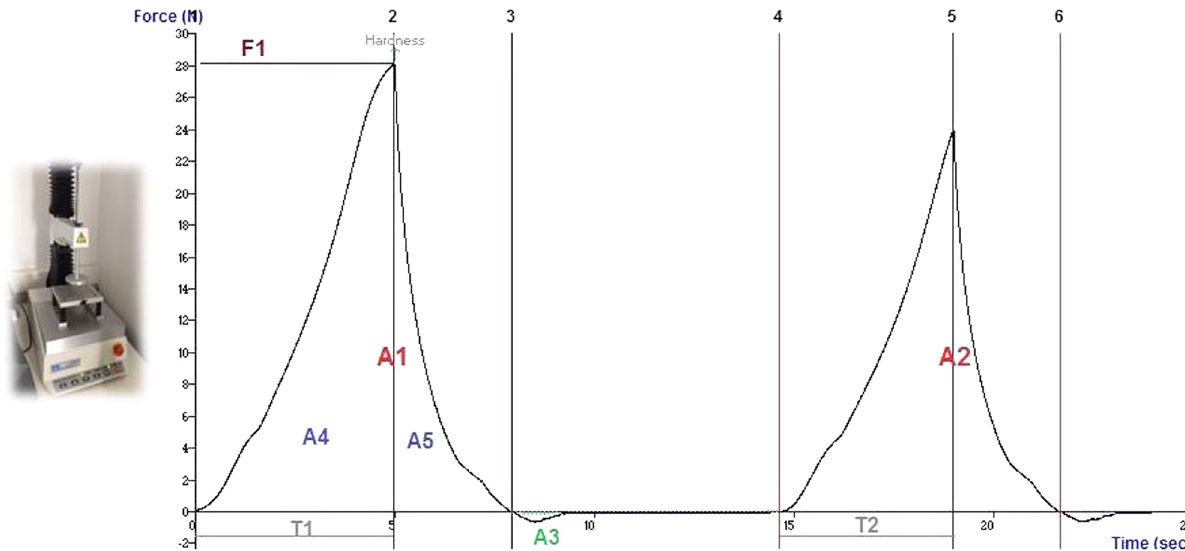
Figure 1: Example of a TPA obtained for the sample Strawberry & Anise, making the compression test with the P/75 probe.